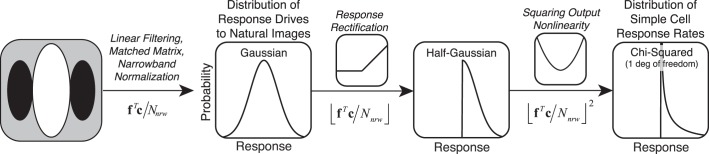
Relating Gaussian response-drive statistics to the statistics of spiking response in cortex. Response drives are first rectified, creating a half-Gaussian distribution. Rectified response drives are then squared, creating a chi-square distribution. The predicted distribution of simple-cell response rates in early visual cortex is the chi-square distribution with one degree of freedom. The predicted distribution of complex-cell response rates in early visual cortex is the chi-square distribution with two degree of freedom (see text).